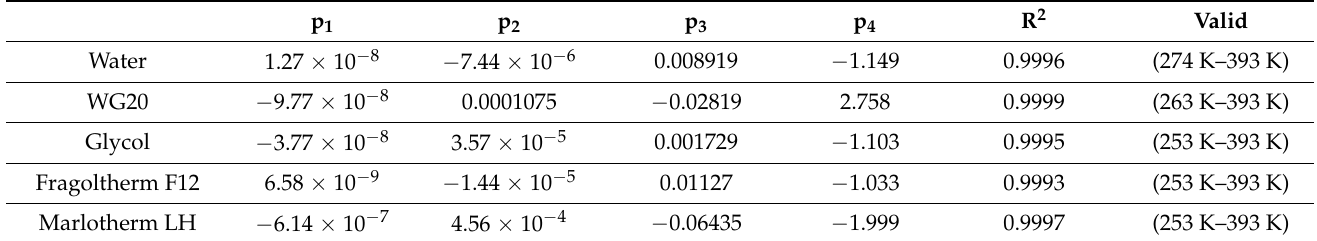
Table 5. Fitting parameters for the temperature two-color